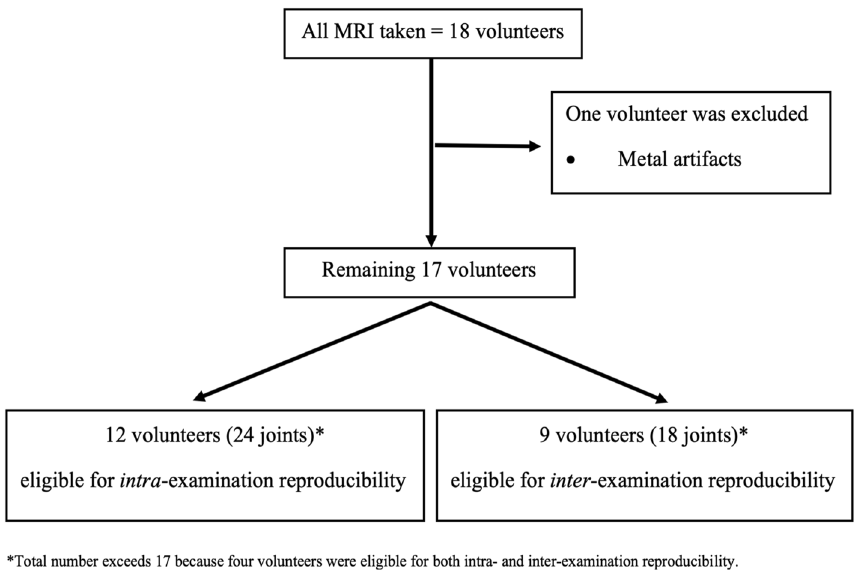
Figure 2. Volunteer selection and distribution